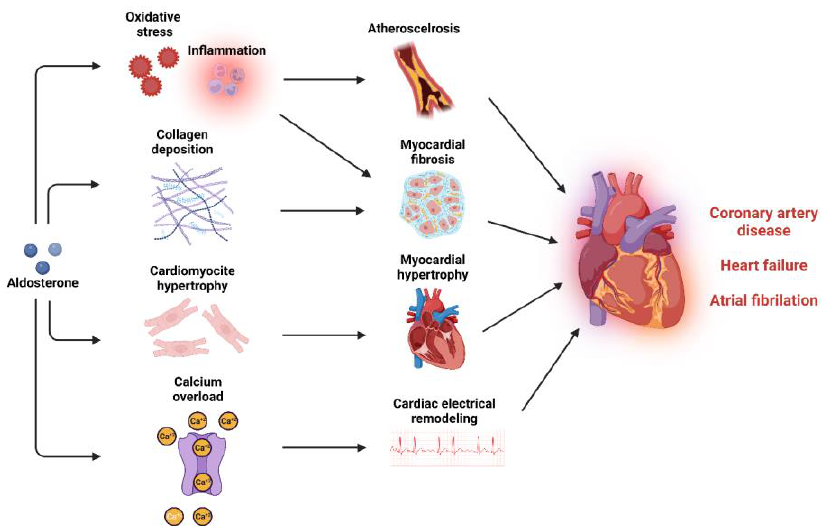
Figure 3. Mineralocorticoid activation and cardiovascular disease. MR activation can induce mul- tiple pathological mechanisms that promote atherosclerosis and myocardial dysfunction and can lead to coronary artery disease, heart failure, and atrial fibrillation.